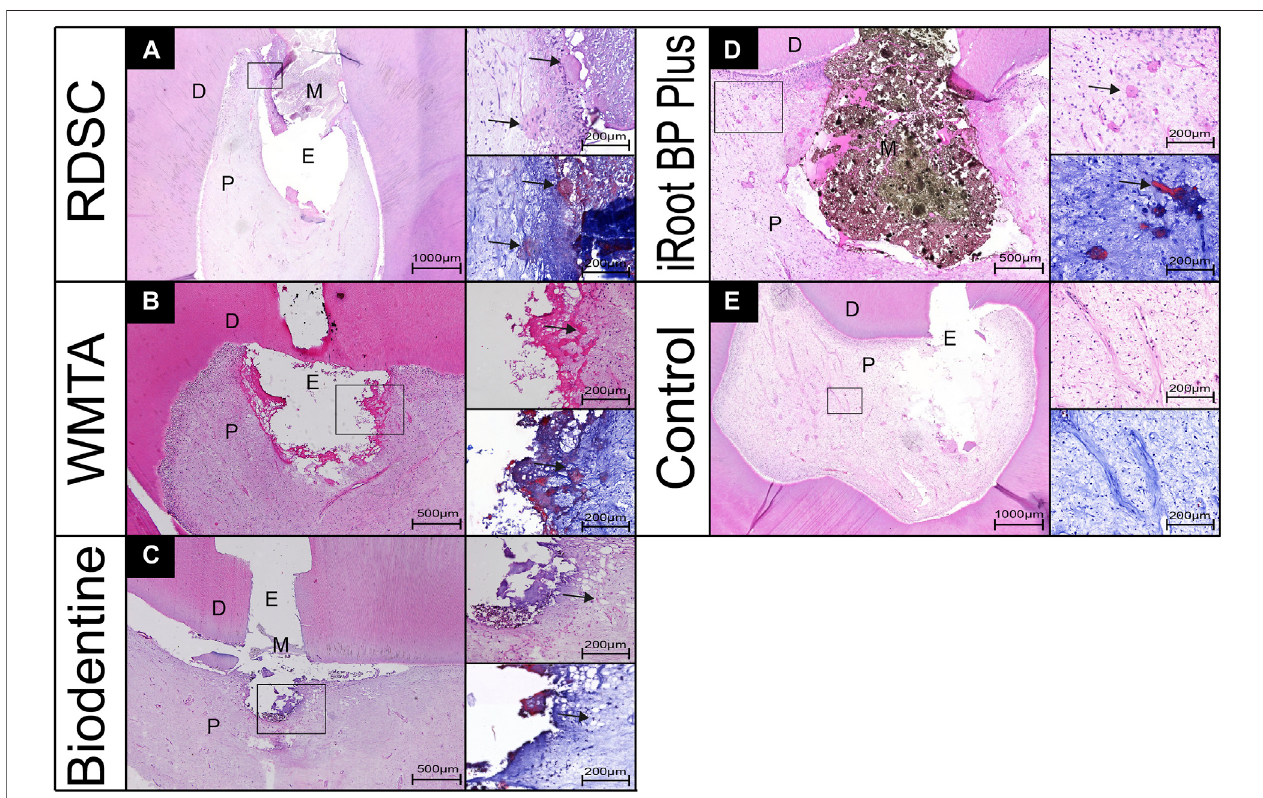
FIGURE5| Pulp-tissueresponseofrepresentativeteethafter7 daysinthehumantooth-culturemodel,withhistologicalmicrographsofpulpsthatwerecappedby RDSC (A) , WMTA (B) , Biodentine (C) , iRoot BP Plus (D) , or the control (E) . (D, dentin; M, materials; E, exposure sites; P, pulp tissue, arrows: mineral foci).